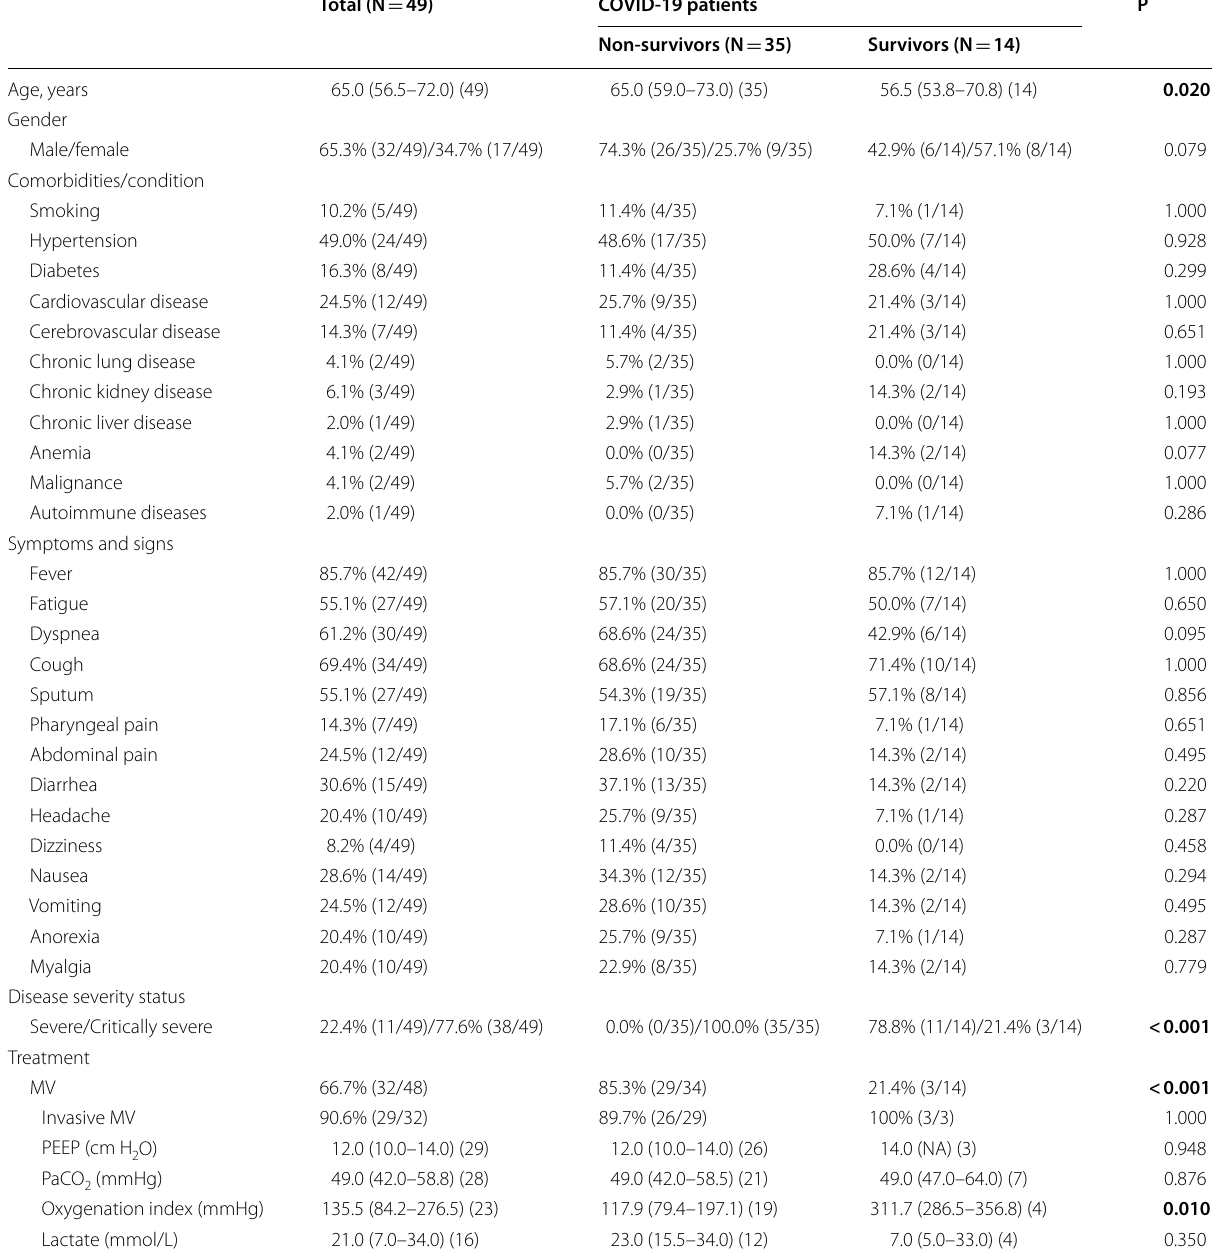
Bold values indicate statistical significance Data are presented as median (Q1–Q3) (N) or % (n/N) COVID-19, coronavirus disease 2019; MV, mechanical ventilation; PEEP, positive end-expiratory pressure; PaCO 2 , partial pressure of carbon